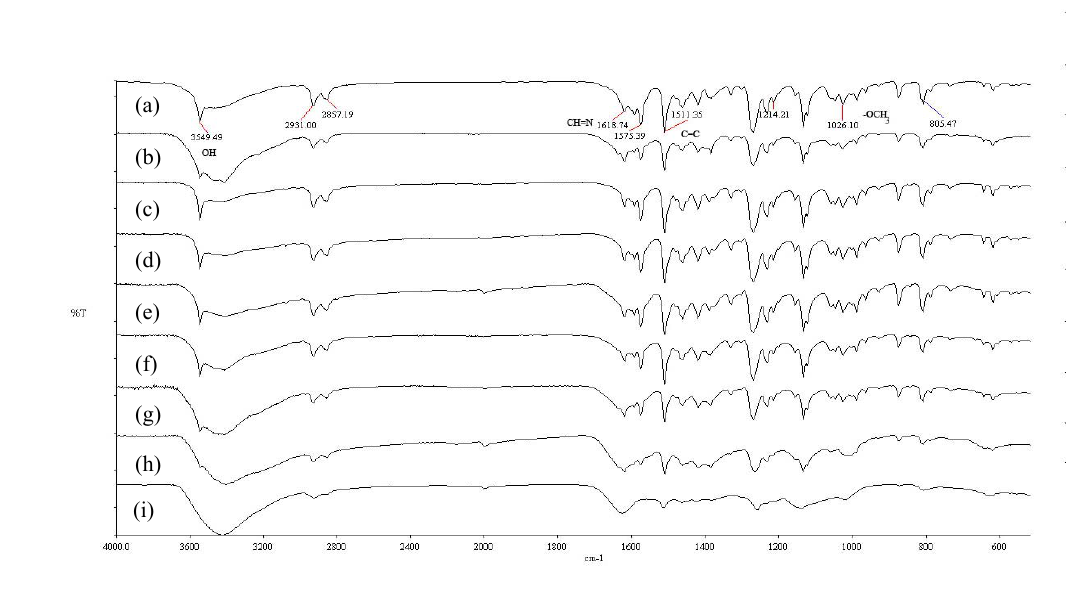
Figure 3. FT-IR spectra for CdS: Ia nanocomposites of (a) pure Ia and (b-i) mass compositions of 0.1:1.0 to 1.0:1.0 (w/w).